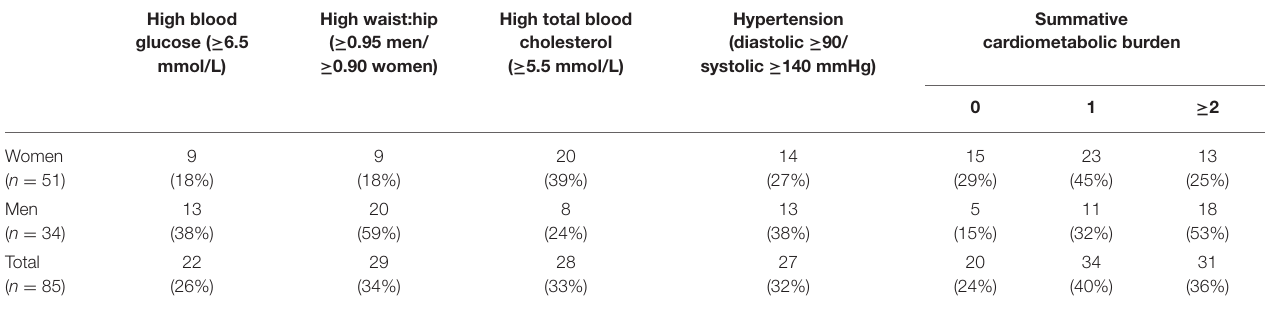
TABLE 1 | Distribution of cardiometabolic burden across